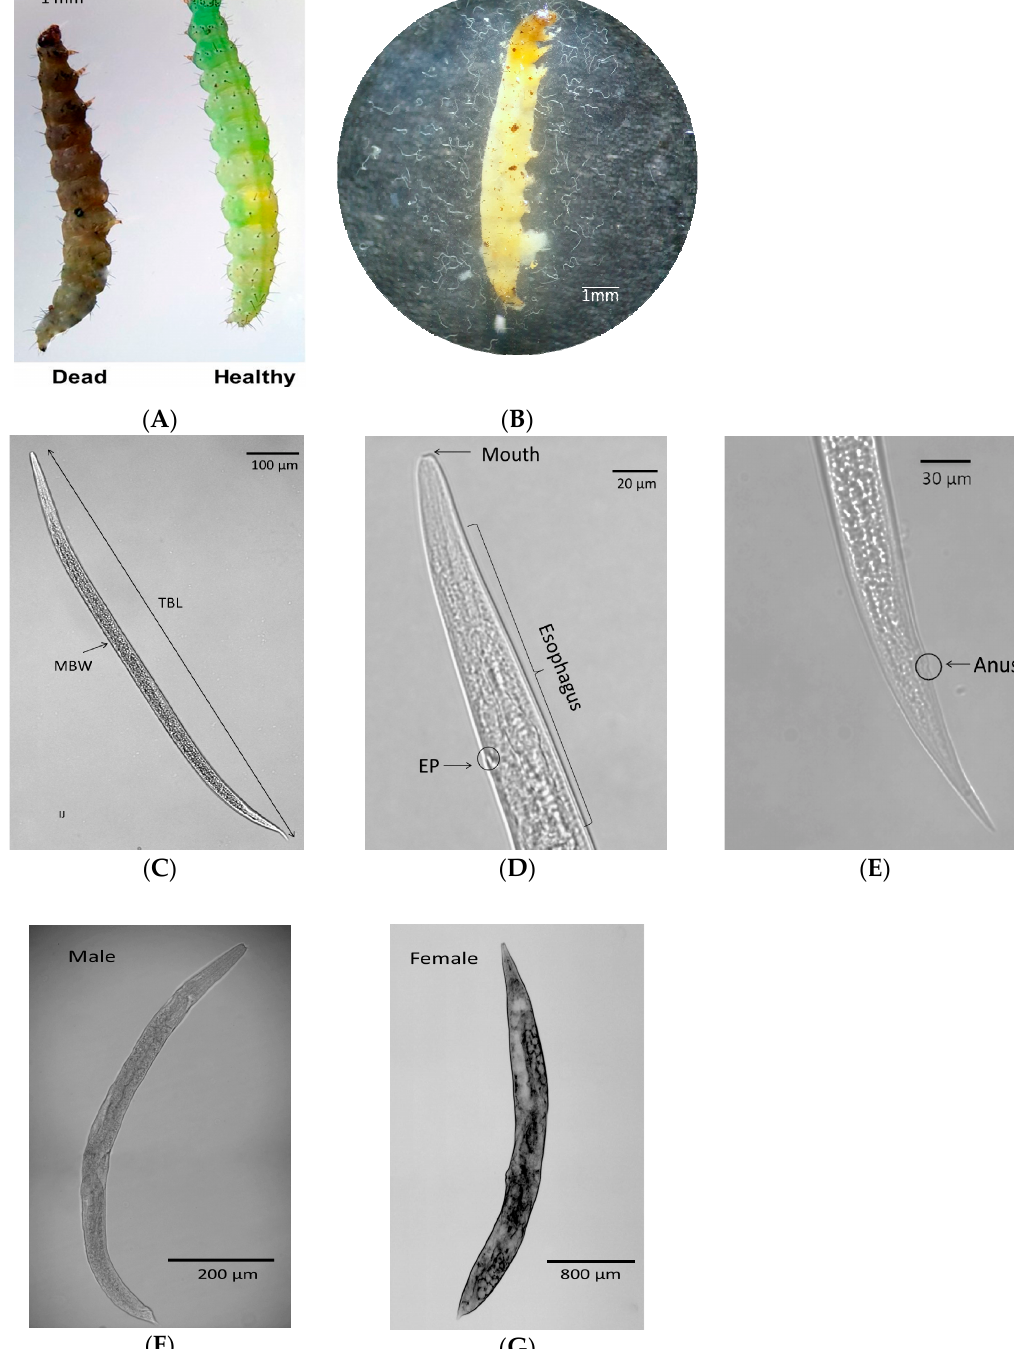
Figure 1. Morphological structures of S. feltiae isolate at different developmental stages. ( A ) Dead symptom of P. xylostella larva infected with the nematode isolate. ( B ) Multiplied nematodes released from the insect cadaver. ( C ) Whole body shape of the isolate infective juvenile (IJ). ( D ) IJ esophagus and excretory pore in circle. ( E ) IJ tail showing anus in circle. ( F ) Whole body of an adult male. ( G ) Whole body of an adult female. Table 1. Identification of an EPN isolate using ITS sequence. The sequence region (950 nucleotide (nt)) contains partial 18S rRNA (141 nt), ITS1 (276 nt), 5.8S rRNA (154 nt), ITS2 (301 nt), and partial 28S rRNA (78 nt)